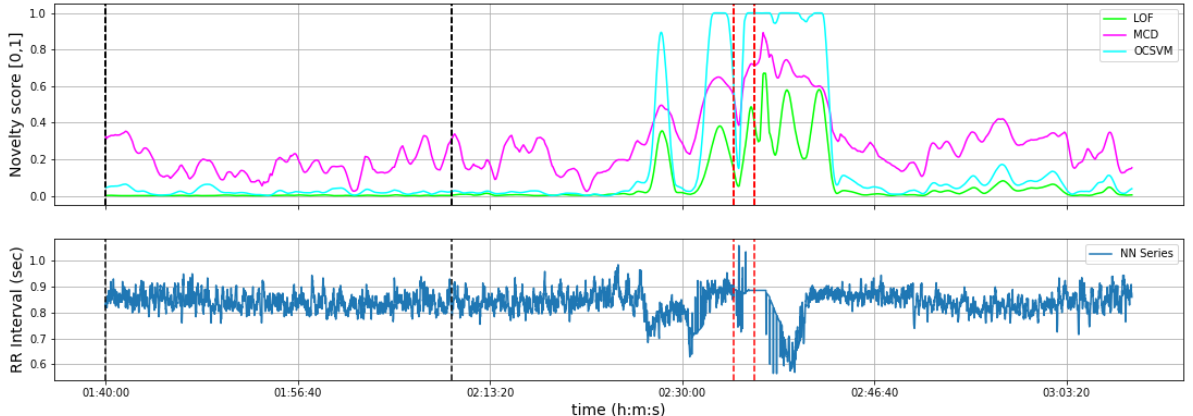
Figure 2. NN series novelty monitoring examples. Anomaly scores are averaged over 50 consecutive segments and min-max scaled. The black dashed lines correspond to the reference interval whereas the red lines correspond to the seizure event.